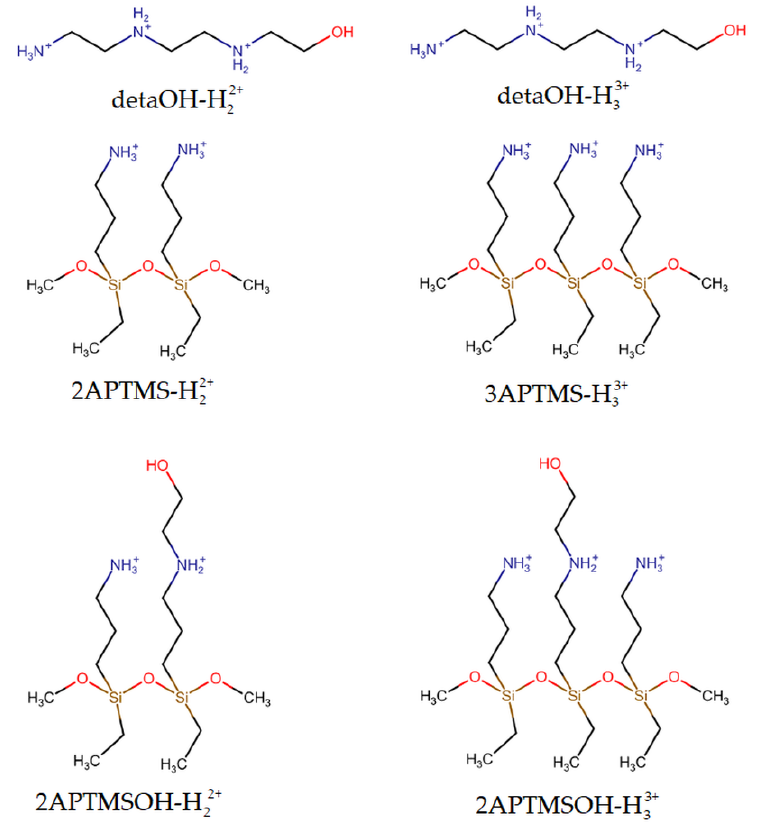
Figure 11. The structures of sorption sites used in model systems for estimation of the binding energies of oxyanions to polymeric nanocomposite.